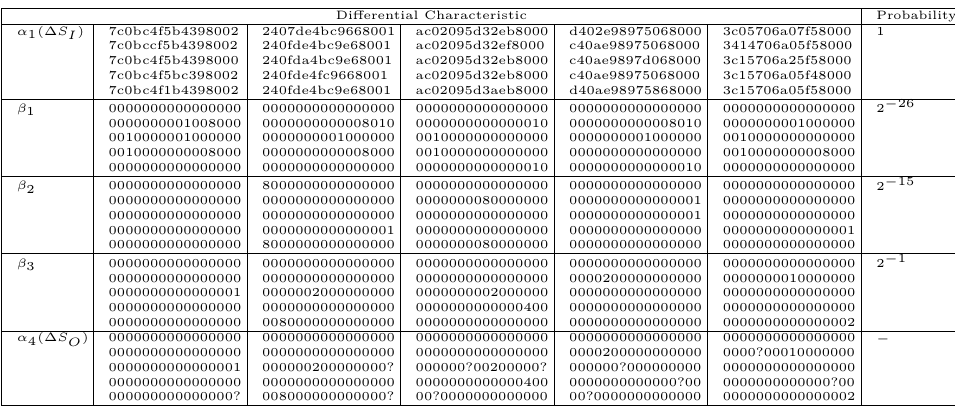
Table 4: The 3-round differential